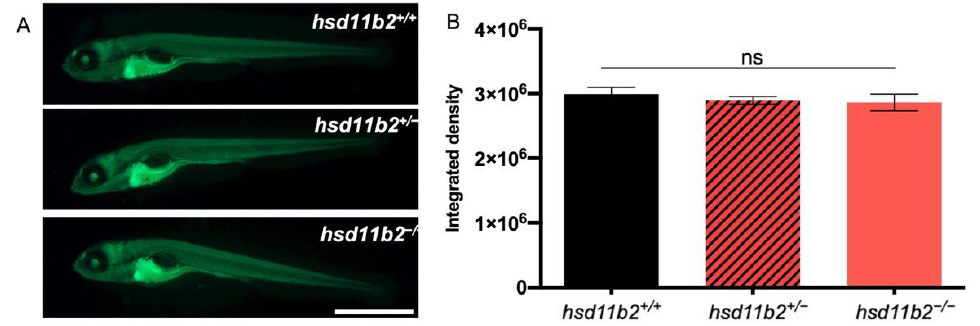
Figure 5. Analysis of GC-dependent transcriptional activities. ( A ) Representative pictures of 5-dpf hsd11b2 +/+ , hsd11b2 +/− , and hsd11b2 −/− larvae in Tg(9xGCRE-HSV.Ul23:EGFP) ia20 transgenic background. ( B ) Fluorescence quantification of 5-dpf hsd11b2 +/+ , hsd11b2 +/− , and hsd11b2 −/− larvae in Tg(9xGCRE- HSV.Ul23:EGFP) ia20 transgenic background. Scale bar = 1 mm. Statistical significance was deter- mined by Student’s t -test. ns = not significant. Mean ±